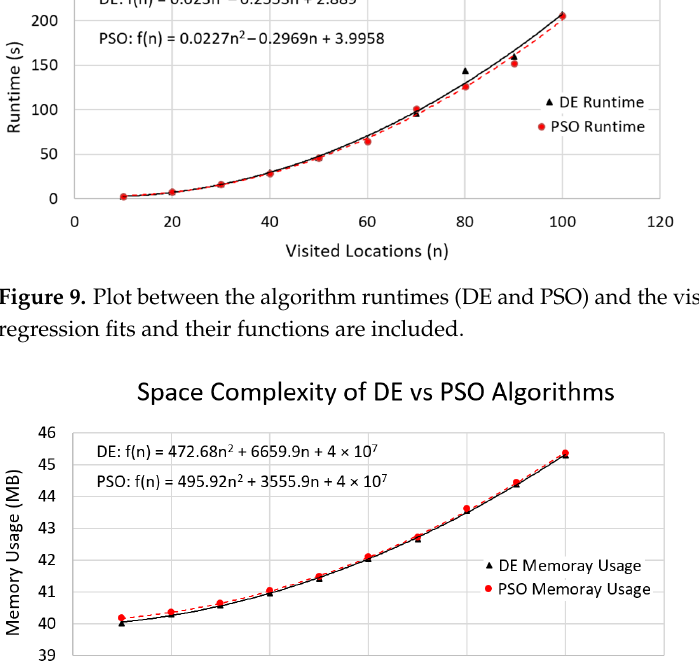
Figure 10. Plot between the algorithm memory usage (DE and PSO) and the visited locations. The quadratic regression fits and their functions are included. quadratic regression fits and their functions are